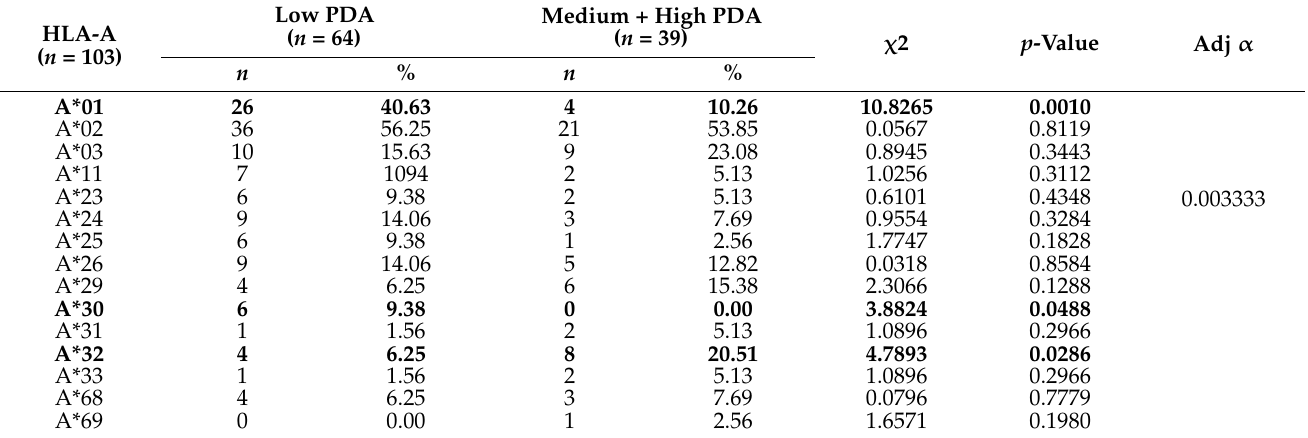
Table 1. Correlation between PDA and HLA-A.